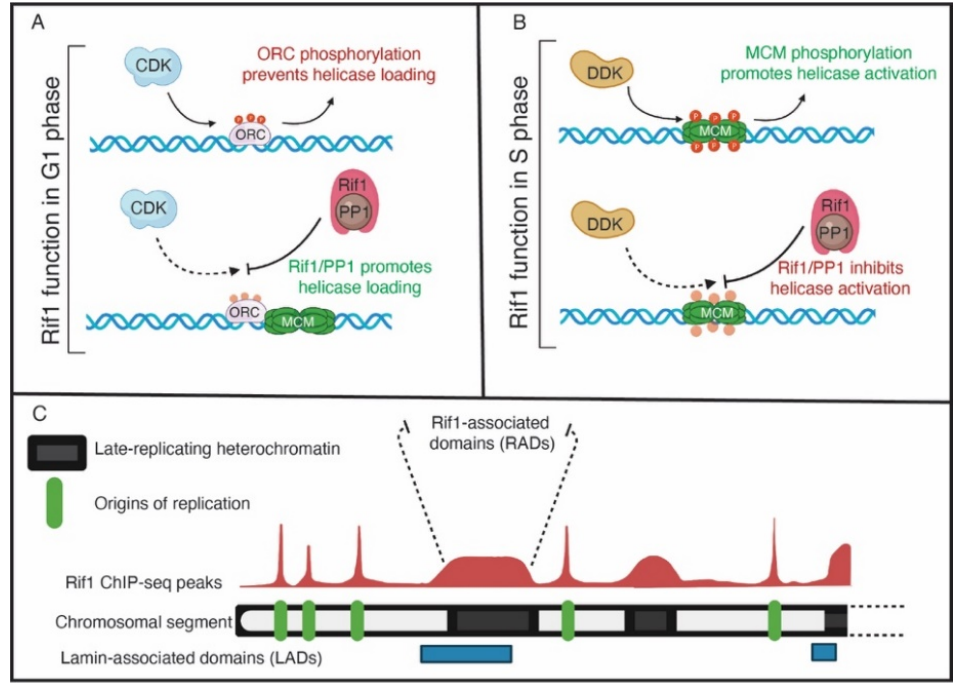
Figure 2. The functions of Rif1. ( A ) In G1 phase, Rif1 may reverse the CDK-mediated phosphorylation of ORC to promote ORC-dependent loading of MCMs. ( B ) In S phase, Rif1 opposes DDK-mediated MCM phosphorylation to inhibit helicase activation and origin activation in late-replicating genomic regions. ( C ) A representative view of Rif1 genomic binding on a chromosomal arm. Green boxes denote origins of replication, where Rif1 genomic binding has a sharp, well-defined peaks. Black boxes indicate regions of heterochromatin, where Rif1 binds to broad domains with a lower signal intensity compared to origins. The broad Rif1 binding domains also have overlap with lamin-associated domains, indicated by blue boxes.